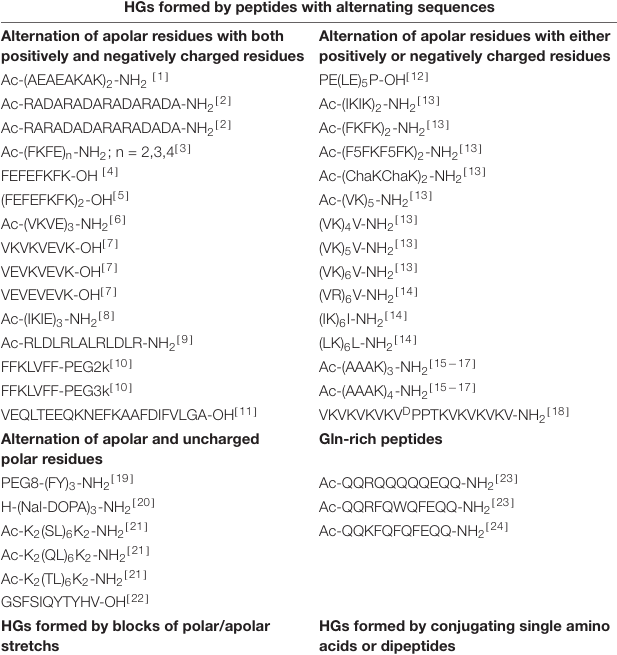
TABLE 1 | Classification of peptide-based hydrogels assuming a cross- β structure with the relative reference. HGs formed by peptides with alternating sequences Alternation of apolar residues with both Alternation of apolar residues with either positively and negatively charged residues positively or negatively charged